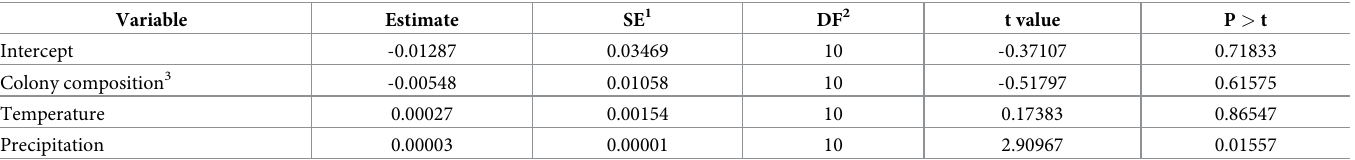
Table 1. Parameter estimates from a linear mixed-effects model for evaluating the effects of environmental variables. The effect of emperature, precipitation and col- ony composition (mixed-species or species-specific) were evaluated on Plasmodium diversity (nucleotide diversity).